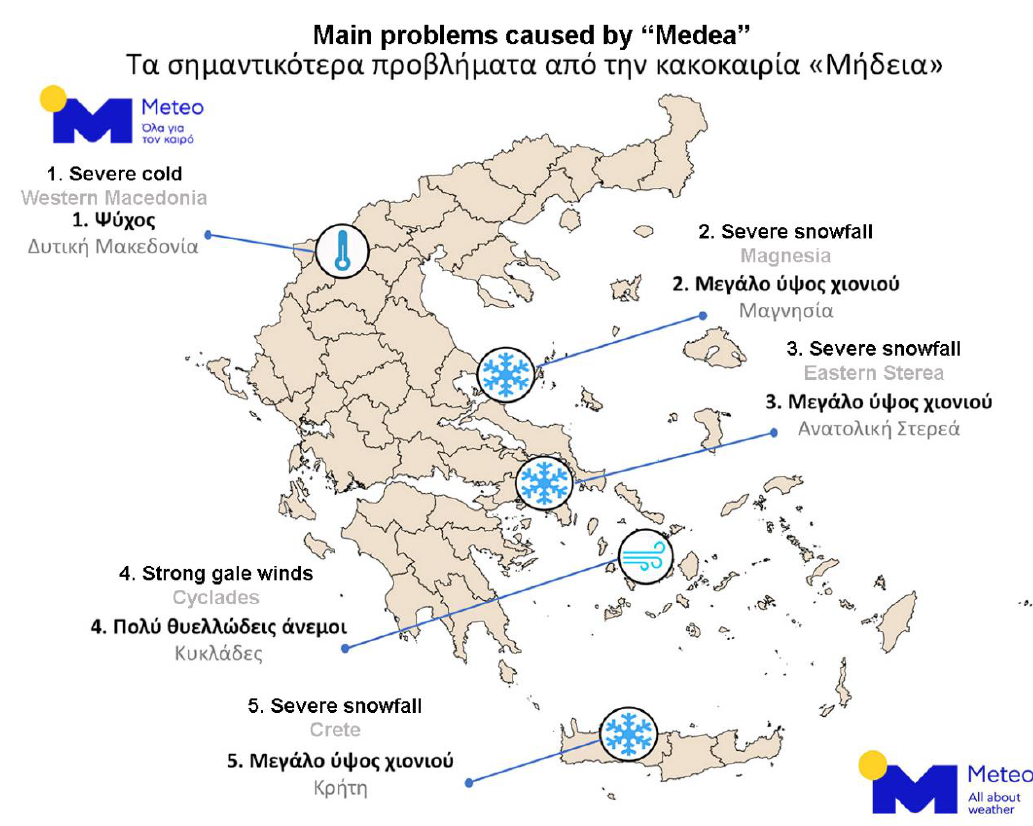
Figure 7. Main problems caused by MEDEA as provided in the original (with English subtitles for the needs of this work).